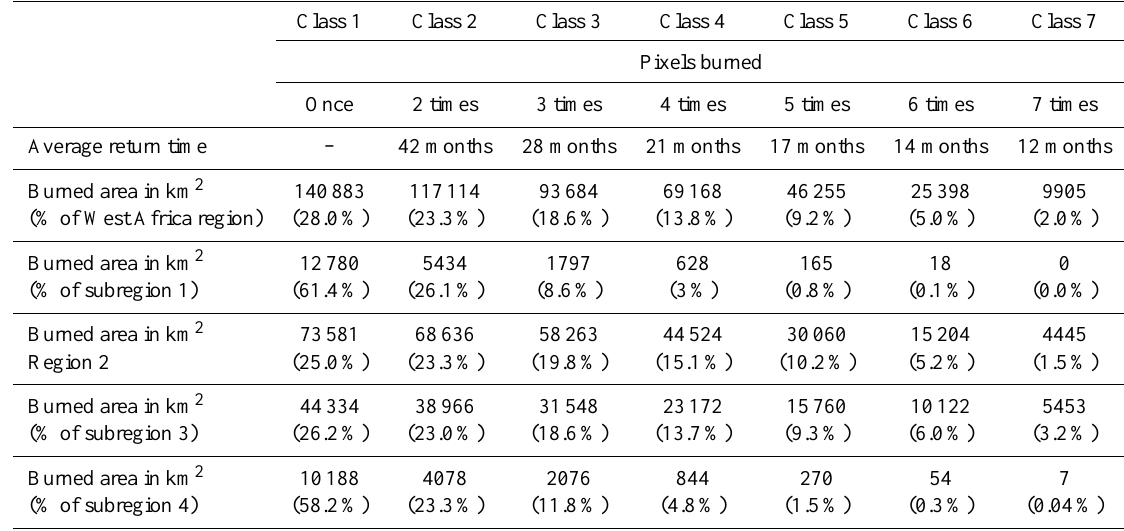
Table 2. Fire return time on the same pixels where fire occurred more than once between 1 April 2000 and 31 March 2007. Their proportions (%) are given in